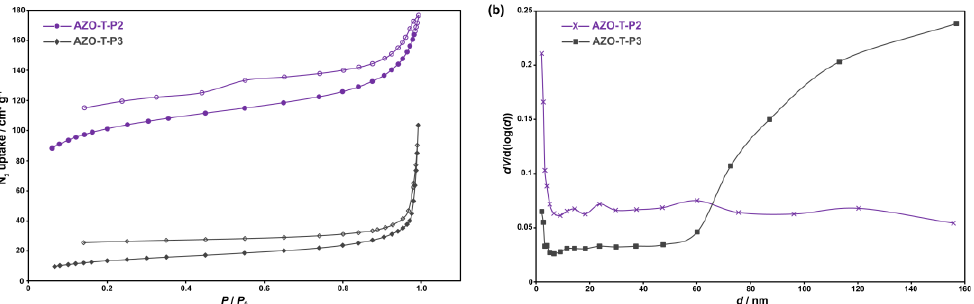
Figure 5. ( a ) N 2 adsorption – desorption isotherms of AZO-T-P2 and AZO-T-P3 measured at 77 K. The adsorption and desorption isotherms are depicted with filled and open markers, respectively; ( b ) pore size distributions of AZO-T-P2 and AZO-T-P3. Table 1. BET surface areas (S BET ) of AZO-B-Ps and AZO-T-Ps.